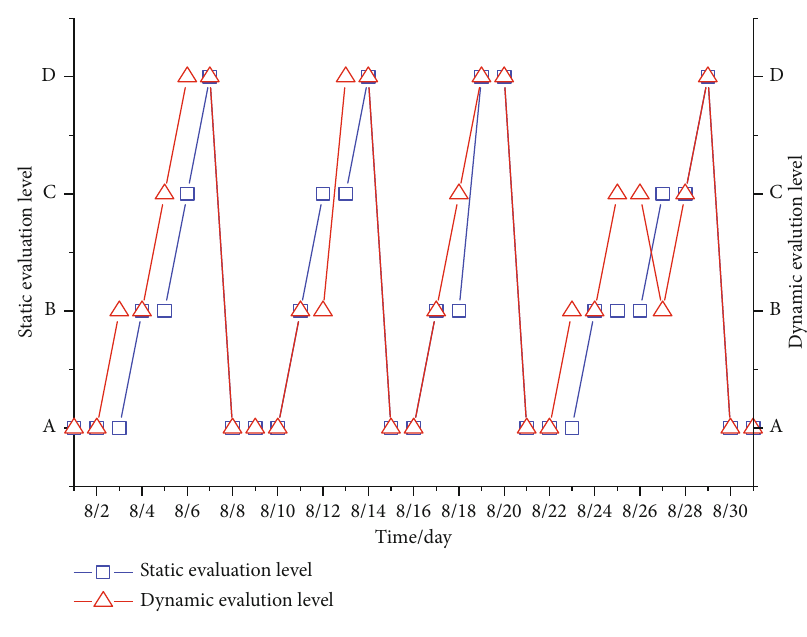
Figure 8: Coal bump risk assessment level from Aug 1 to